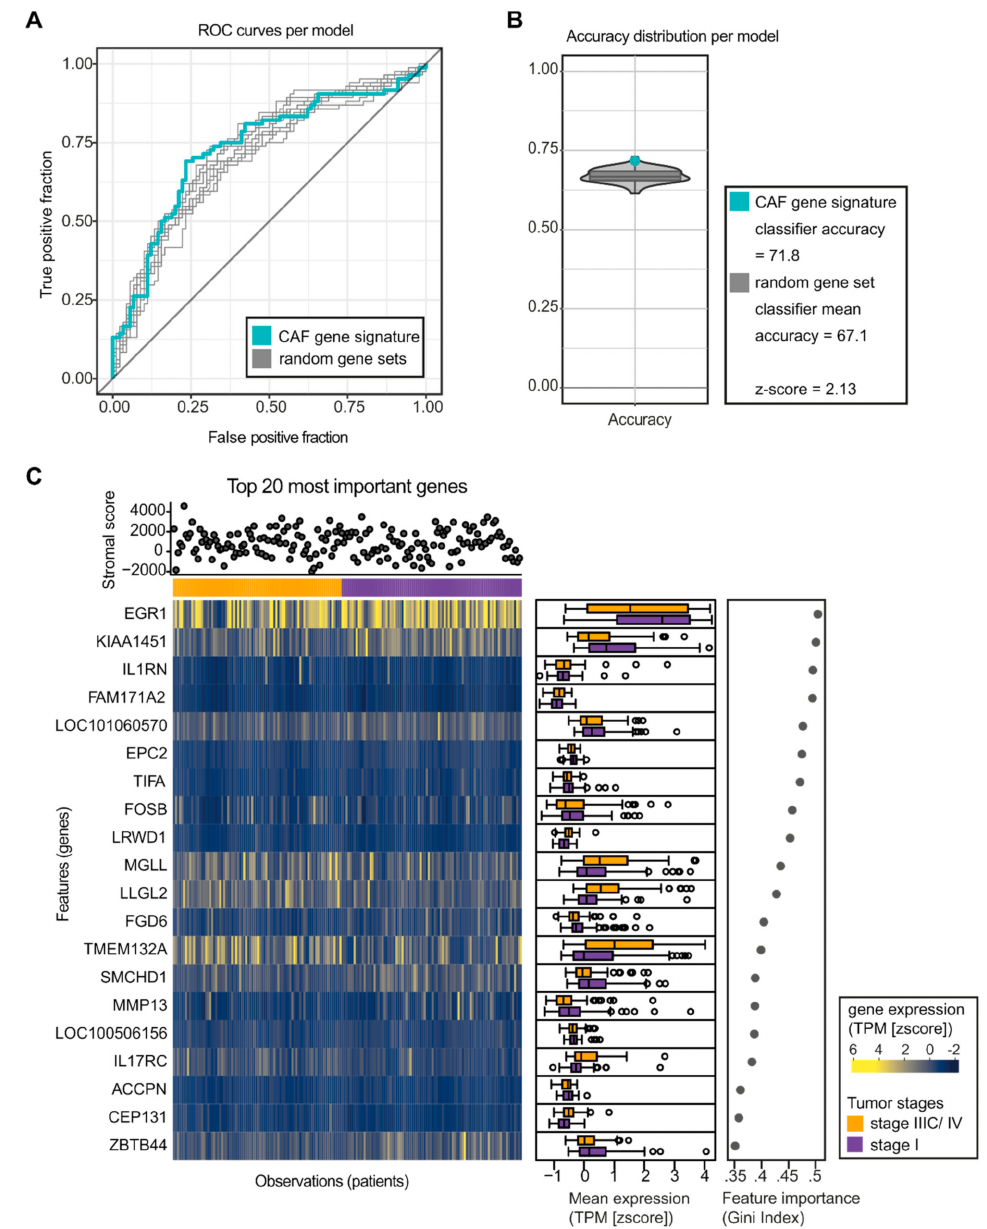
Figure 8. Random forest (RF) analysis to classify tumor stages in mammary carcinoma patients. A RF analysis was used to test the predictive power of the murine cancer-associated fibroblast (CAF) gene signature in staging of human breast cancer (patient cohort from TCGA dataset). ( A ) Receiver operating characteristic (ROC) curves based on the out-of-bag (OOB) error, for the RF trained on the 624 CAF signature genes (blue) and 10 RFs trained on random gene sets. ( B ) Accuracy distribution based on a 10-fold cross-validation for RFs trained on 100 randomly sample gene sets (grey), and the accuracy of the CAF signature gene set (blue). z -scores were obtained using the accuracy distribution from the 100 random gene sets. ( C ) Heat map that shows the influence of the 20 most informative genes in the RF classification (left). Genes are ordered by Gini index and patients are grouped according to their tumor stage (right). Gene expression is visualized as z -score transformed TPM values. The expression trend per tumor stage is captured for each gene in the form of boxplots (middle). Since the amount of stroma varies between samples, a stromal score is shown for each patient, which indicates the stromal content of each tumor tissue sample